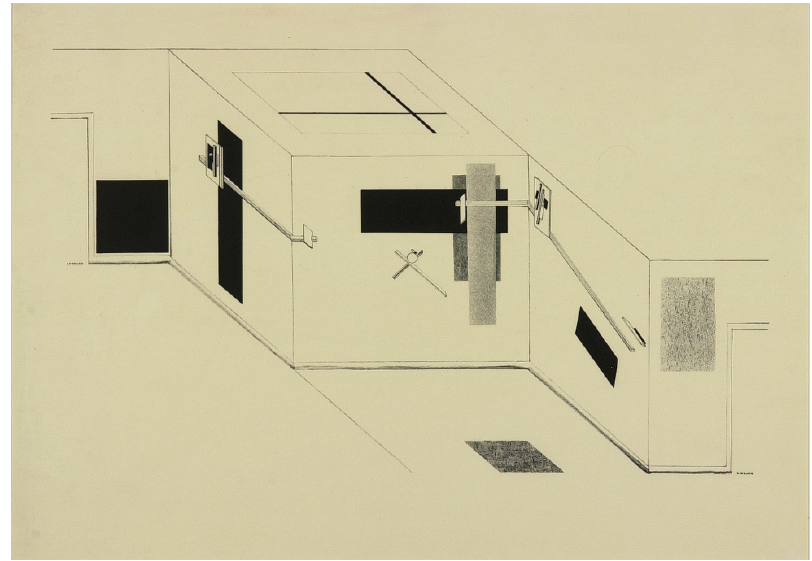
Figure 4. El Lissitzky, Isometric layout of the Prounenraum, lithograph for the ‘Kestner Portfolio’, 1923. Van Abbemuseum. Photo: Peter Cox.